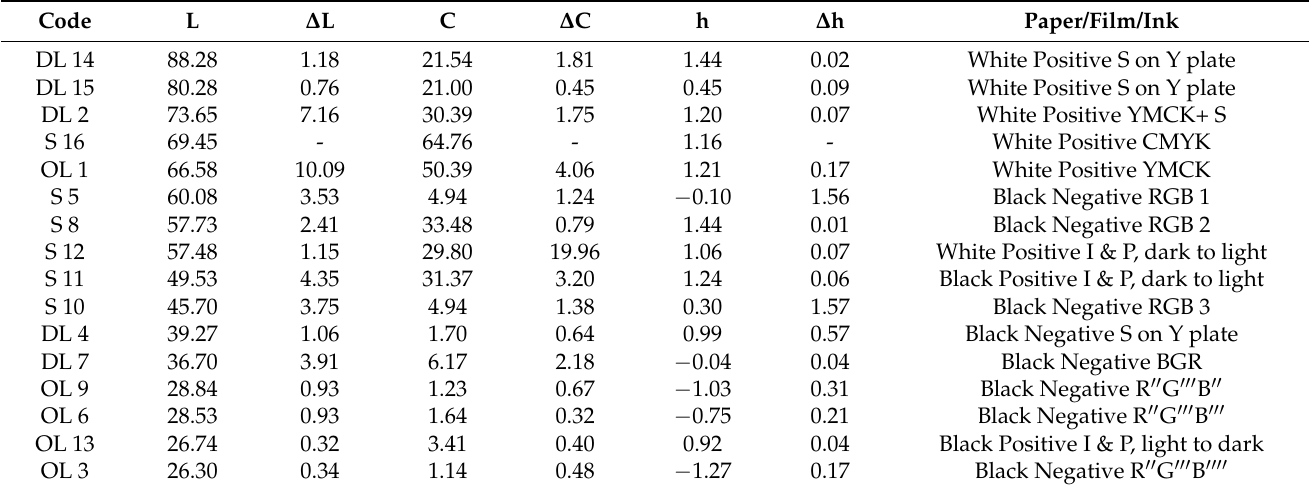
Table 10. Average luminosity, chroma and hue of all amber spots. Ordered according to the higher luminosity value.